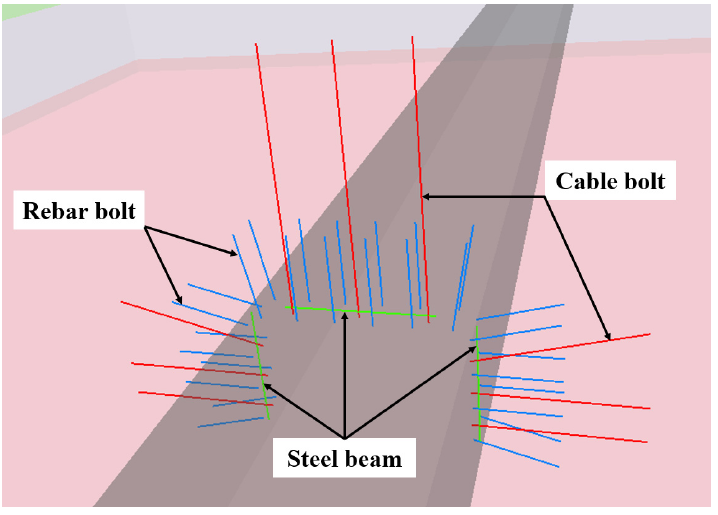
Figure 9. Roadway support design simulation. Table 2. Parameters of the rebar and each cable